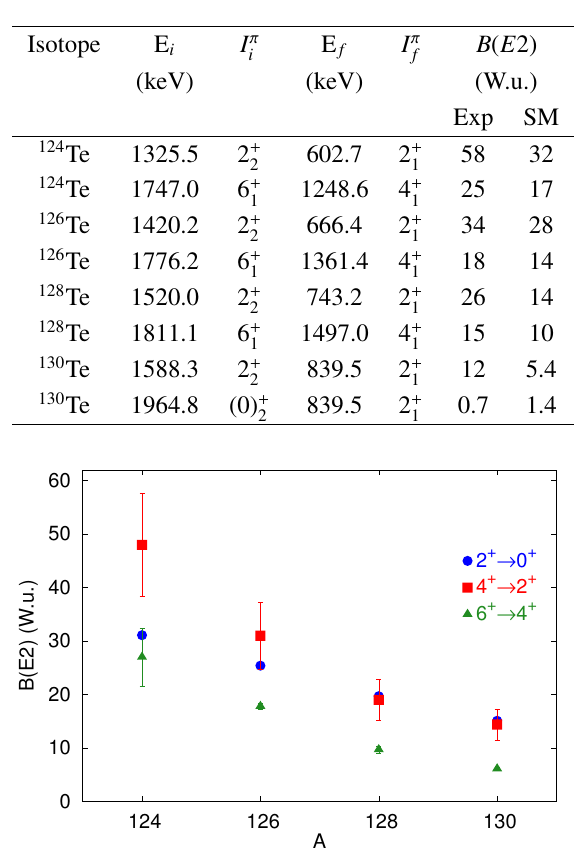
Table 7. Transition strengths in 124 − 130 Te. A 20% uncertainty is assumed for all measured transition strengths. Experimental (Exp) and shell-model (SM) values are presented.